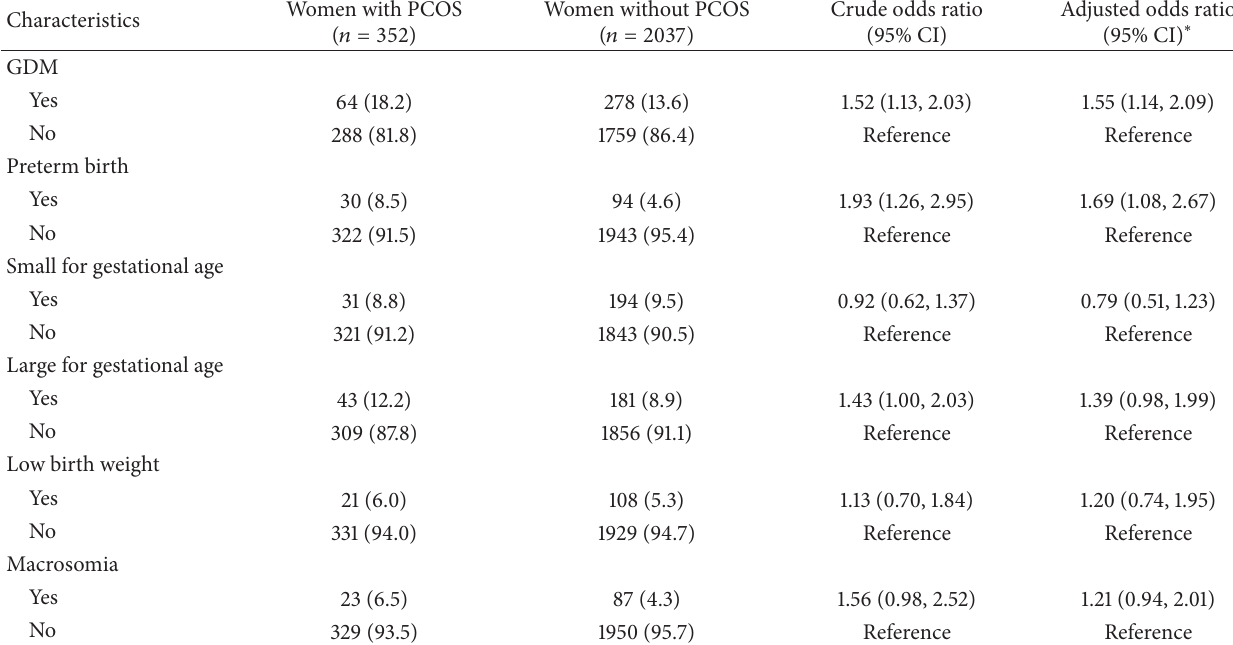
Table 2: Risk of gestational diabetes mellitus (GDM) and adverse birth outcomes in women with polycystic ovary syndrome (PCOS) versus women without PCOS.